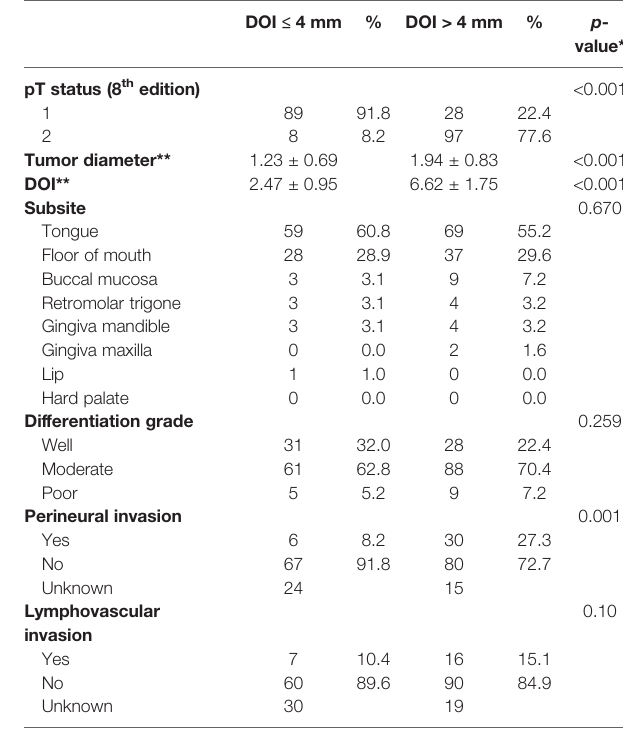
TABLE 2 | Comparison of patient and tumor characteristics for the two depth of invasion